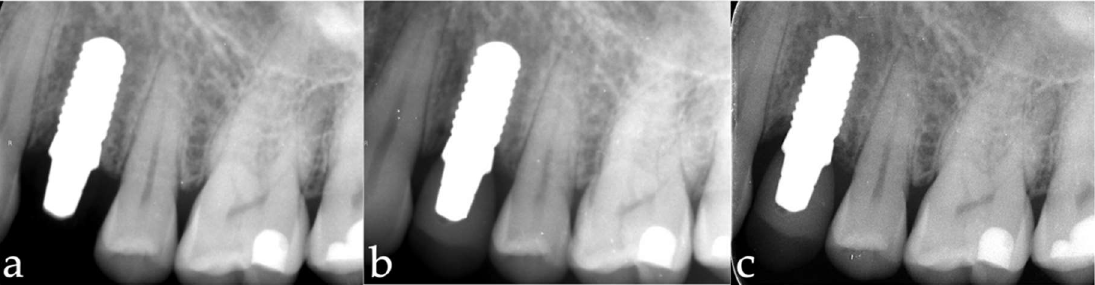
Figure 3. ( a – c ) Radiographic series: ( a ) after implantation; ( b ) crown delivery; ( c ) 1-year follow-up.